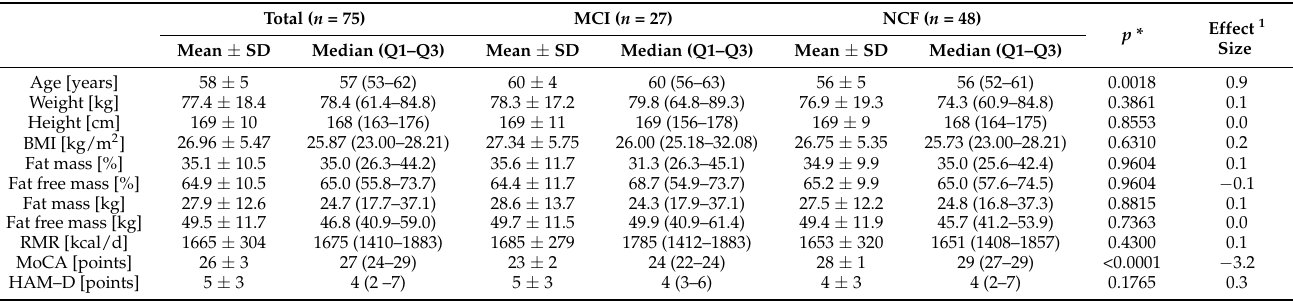
Table 1. Baseline characteristics of the study